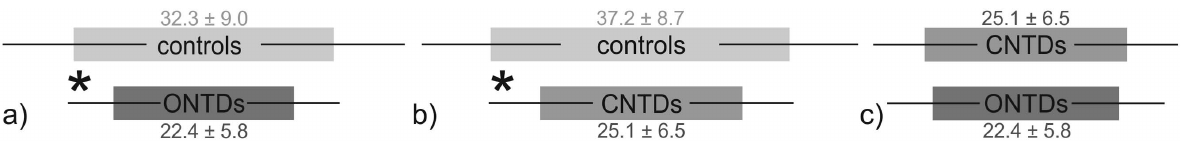
Figure 6. Comparisons of the TDPF in ONTDs, CNTDs and the respective control groups. Bars represent mean values and lines represent standard deviations of the TDPF in fetuses with ONTDs (a, c), in fetuses with CNTDs (b, c) and their respective age matched control fetuses with normal CNS development (a, b). Asterisks indicate significant differences between ONTDs and control fetuses with normal CNS and between CNTDs and control fetuses with normal CNS development (p , .001).